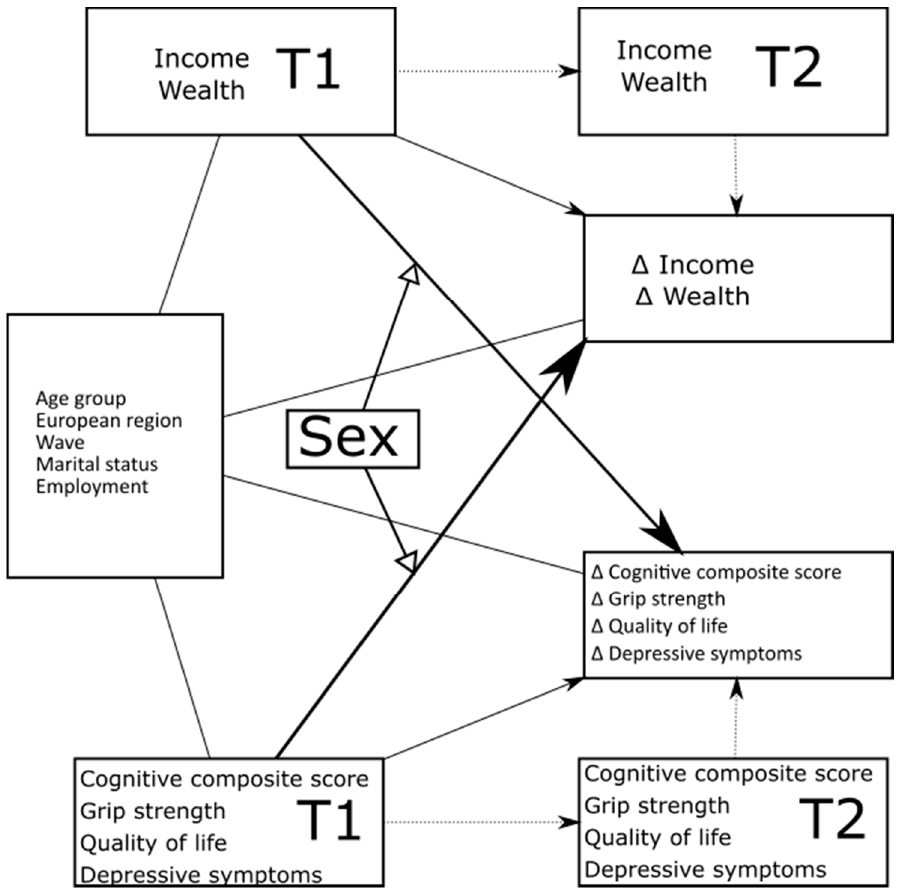
Figure 1. Illustration of the structural equation models used to investigate the dynamic interplay between trajectories of SES and health over time. T1: time point 1, T2: time point 2.